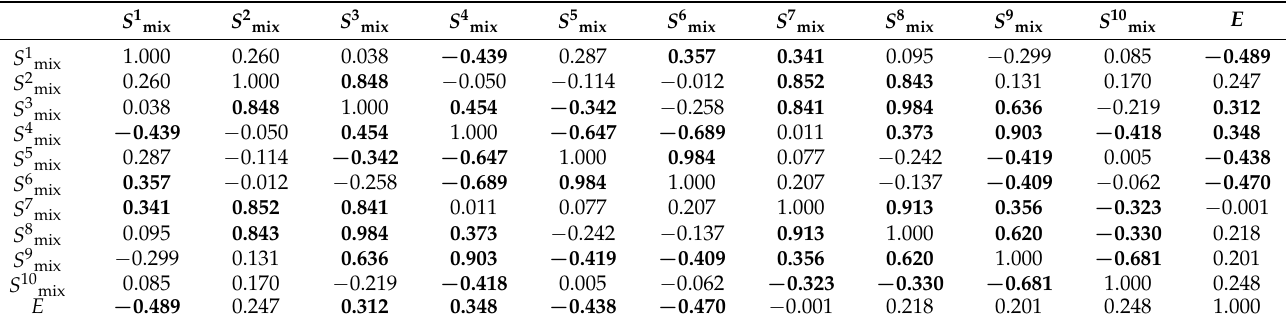
Table 3. Correlation matrix for S i mix descriptors and extraction efficiencies (correlations significant for p < 0.05 are marked